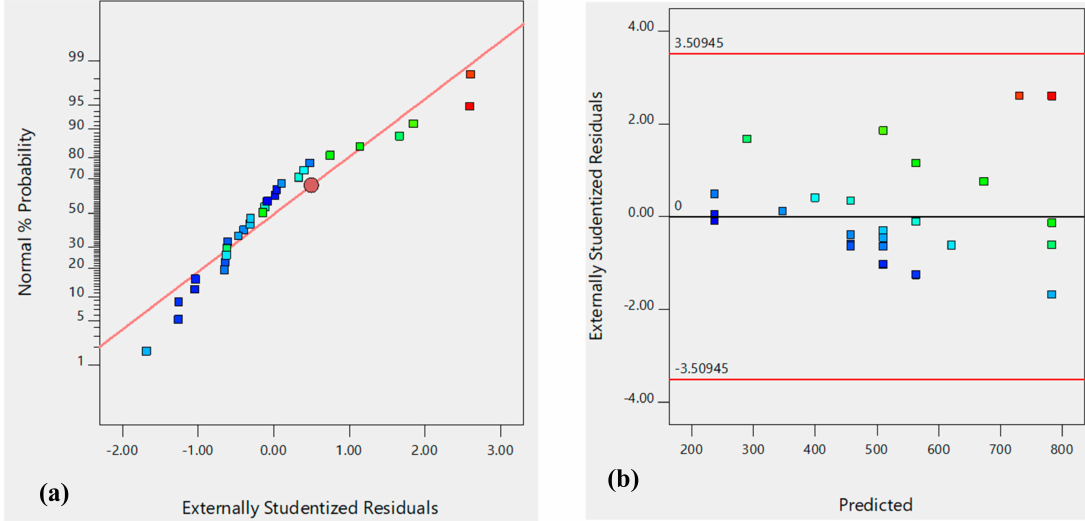
Figure 4. Model adequacy tests for D h response: Normal probability of the externally studentized residuals ( a ), Predicted versus externally studentized residuals ( b